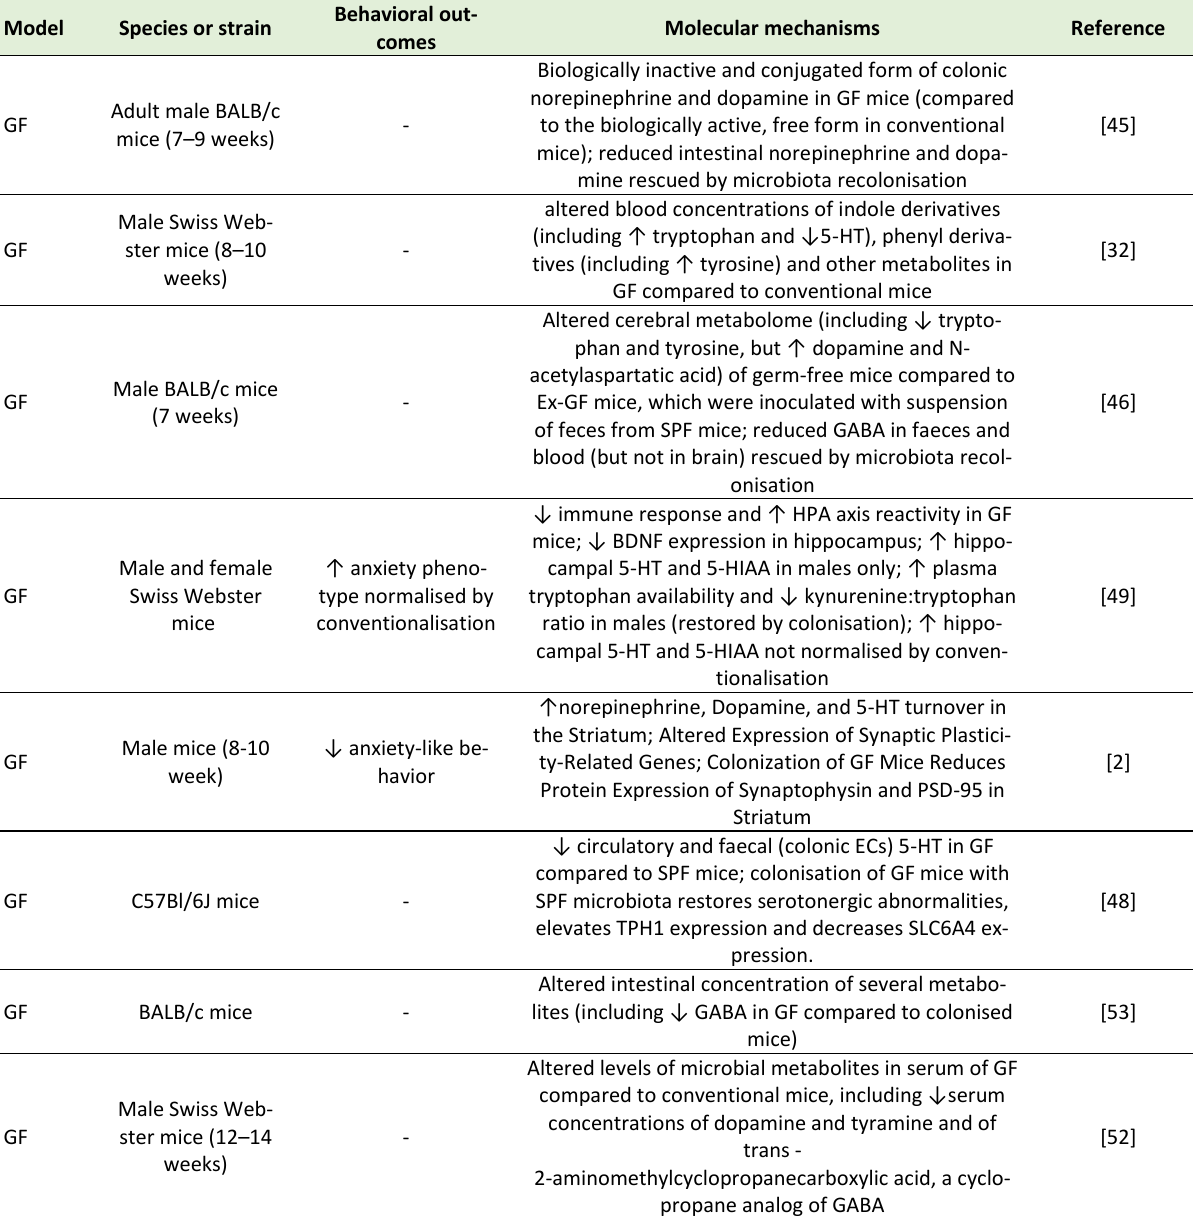
TABLE 1. Studies investigating the effect of a lack of microbiota on neurotransmitter systems.